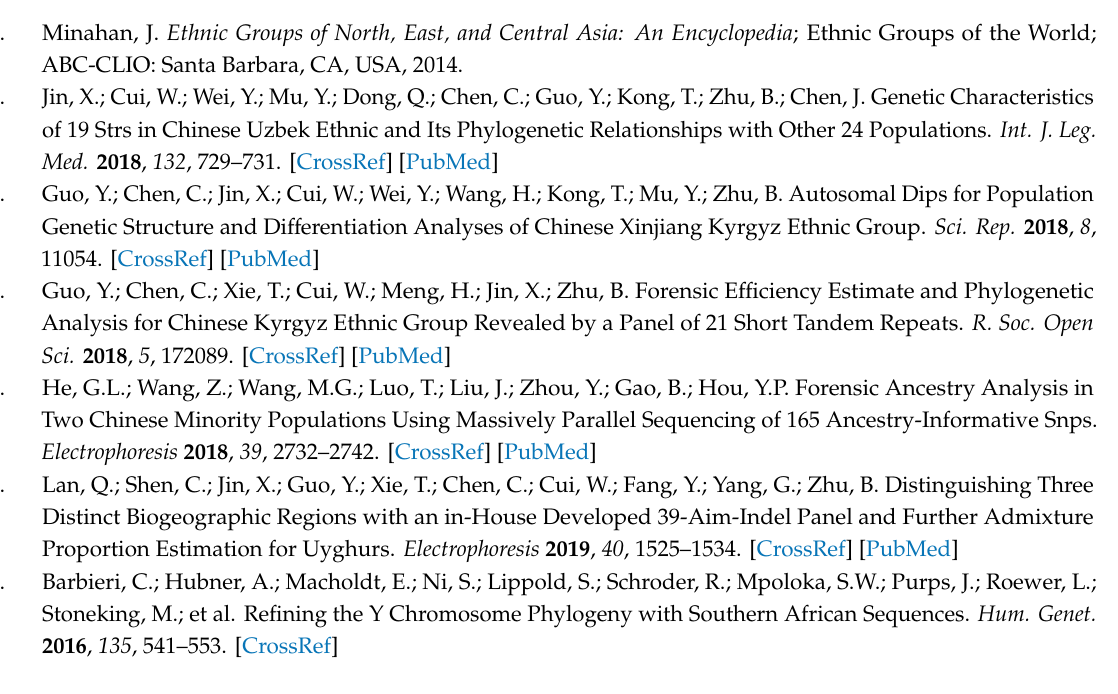
Table S1: The allele frequencies of 60 mtDNA loci in Kyrgyz group ( n = 138), Table S2: Haplogroup frequencies and counts for 59 mtDNA loci except (CA)n in 138 Kyrgyz individuals, Table S3: The allele frequencies and forensic parameters of 24 Y-STRs in Kyrgyz group ( n = 241), Table S4: Haplogroup frequencies and counts for 23 Y-STRs except DYS460 in 241 Kyrgyz males, Table S5: Contingency table for independence tests between 24 Y-STRs and 58 mtDNA SNPs ( n =